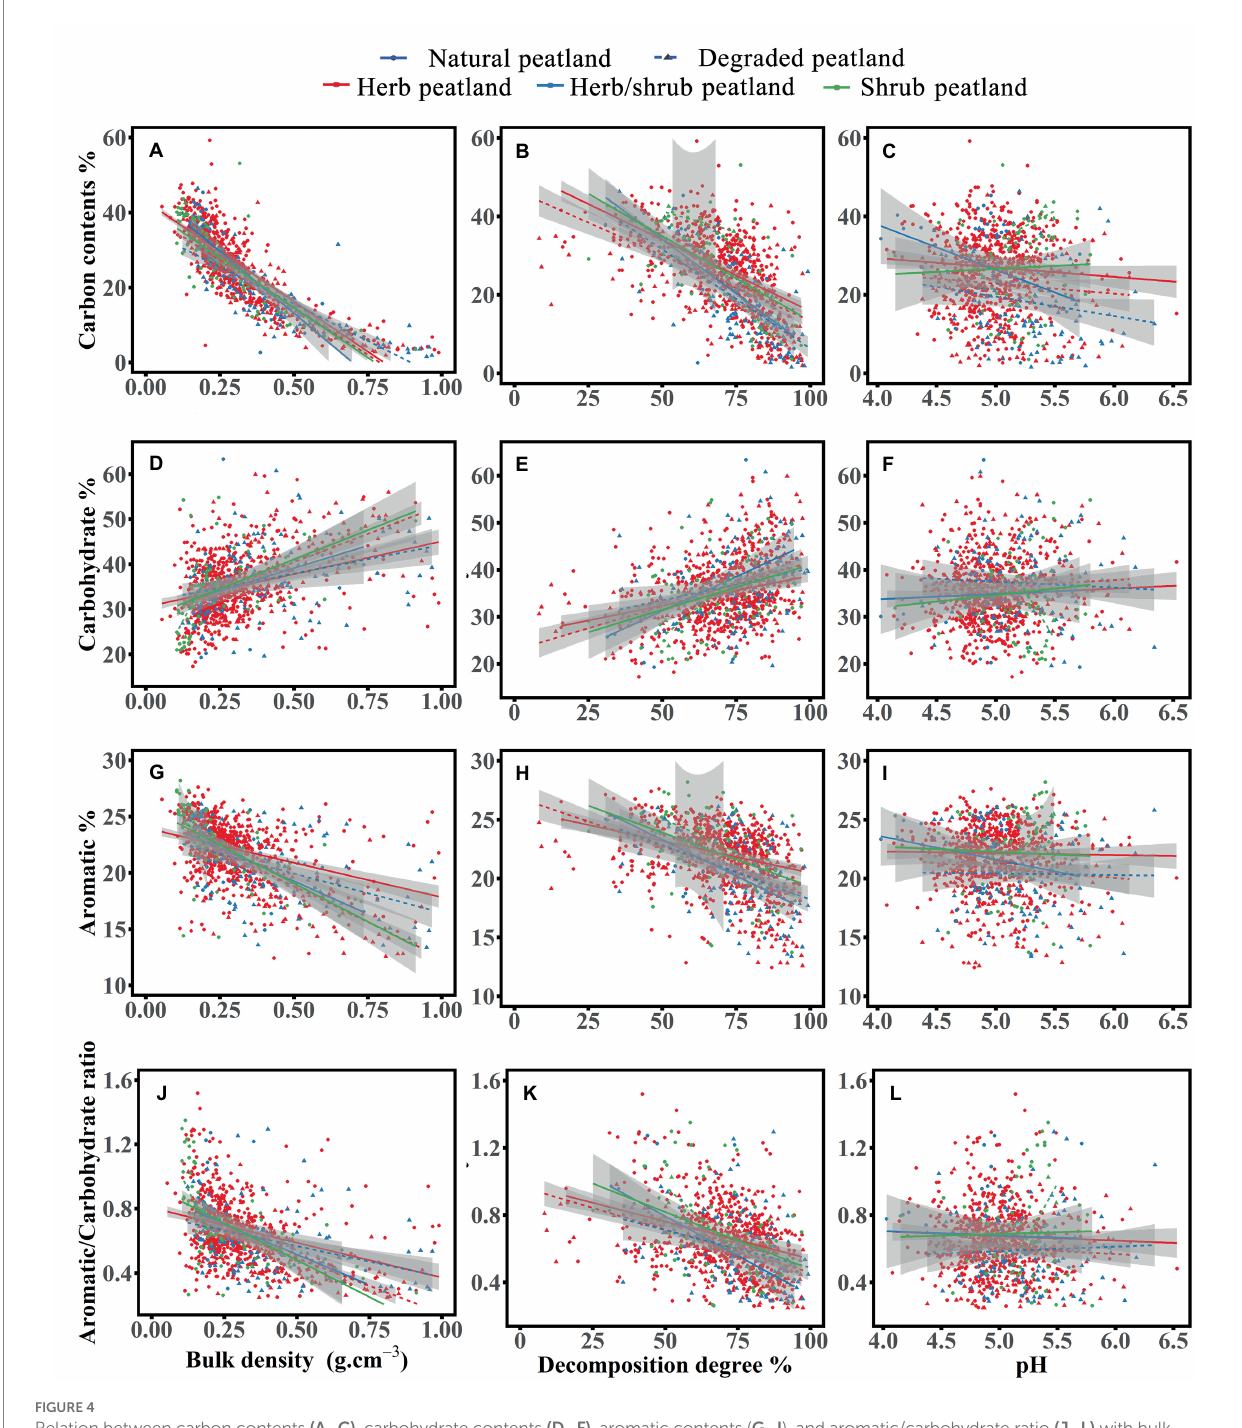
FIGURE 4 Relation between carbon contents (A–C) , carbohydrate contents (D–F) , aromatic contents ( G–I ), and aromatic/carbohydrate ratio (J–L) with bulk density, degree of decomposition, and pH in different dominated plant types of natural and degraded peatland. The trend lines were fitted with a linear model, and the grey shadows indicate 95% confidence interval of fitted